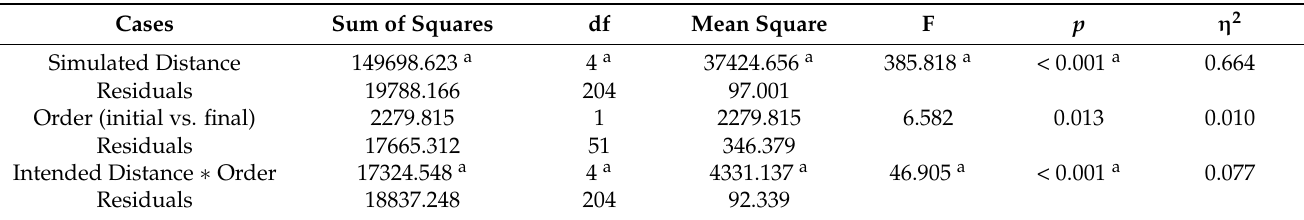
Table A3. Exp 2—repeated-measures ANOVA—comparing target